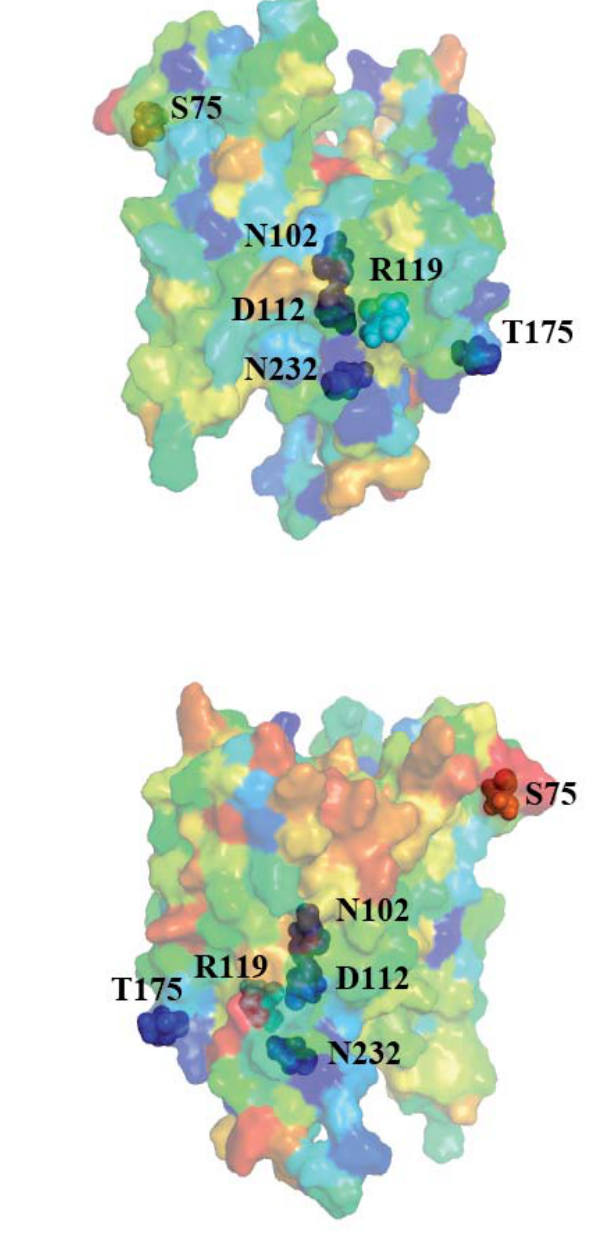
Figure 6. Predicted UBIA prenyltransferase domain-containing protein 1 structure from ModBase mapped with evolutionary conservation scores calculated by ConSurf. Five familial mutations plus one control variant detected in this study are indicated. The color scale ranging from blue to red represents the conservation score of residue varies from 9 (most conserved) to 1 (most variable). a, Front view; b, Rear view.